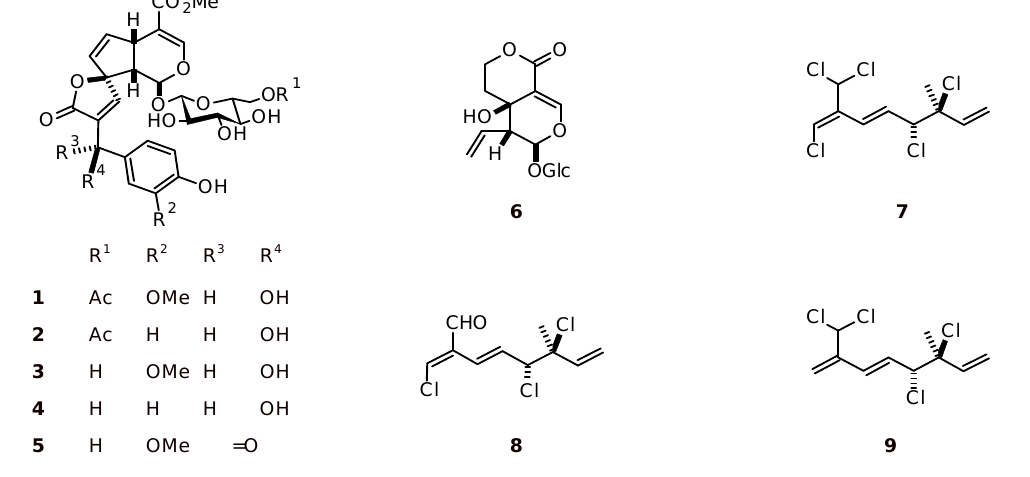
Figure 1. Structures of iridoids and halogenated monoterpenes 1 - 9